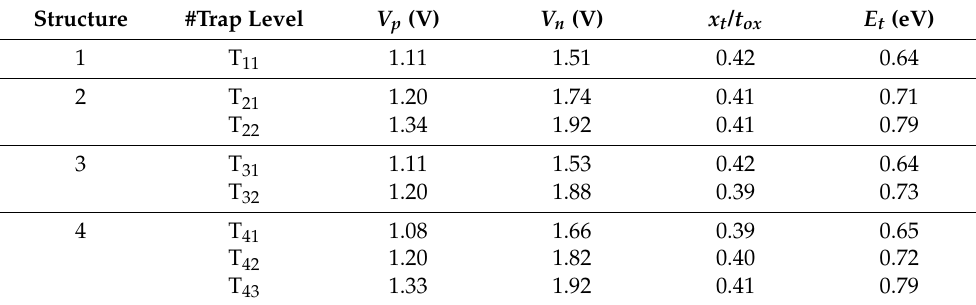
Table 2. Relative position and energy of deep trap levels for different structures.